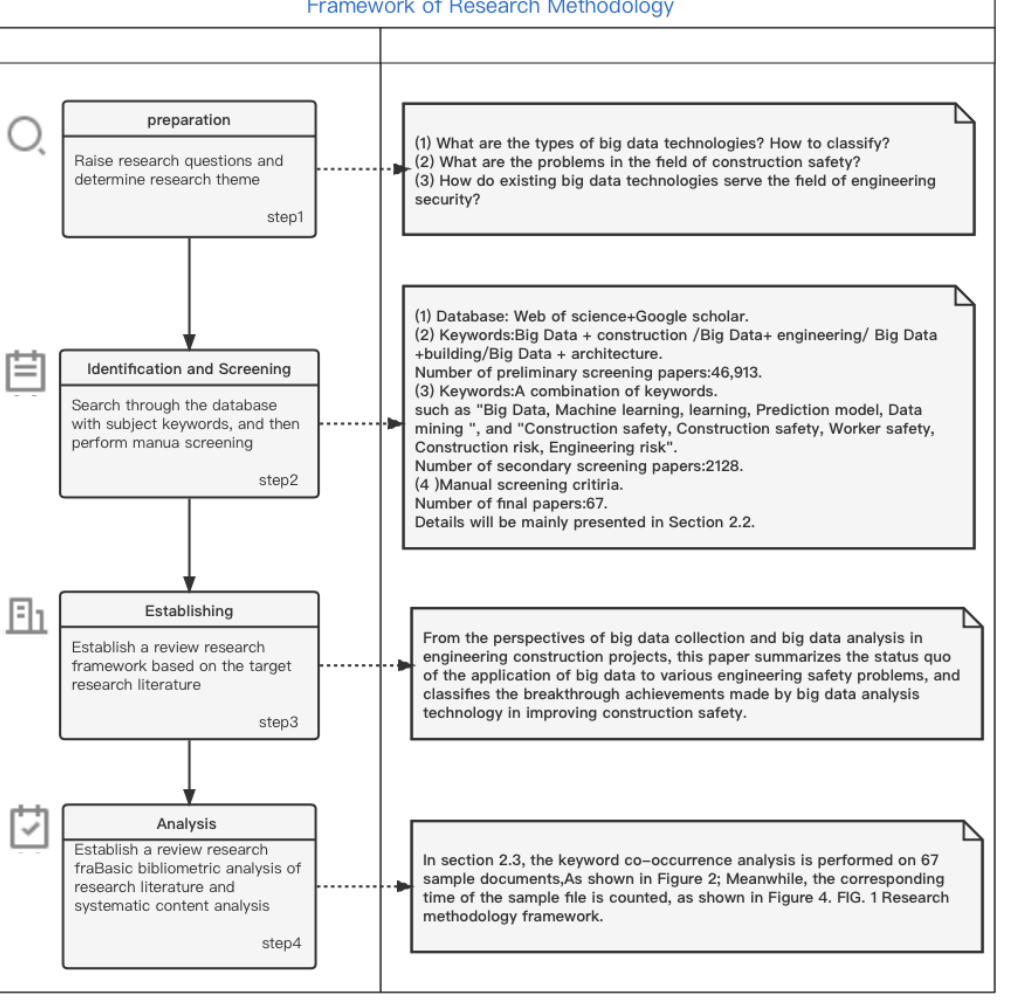
Figure 1. Framework of research